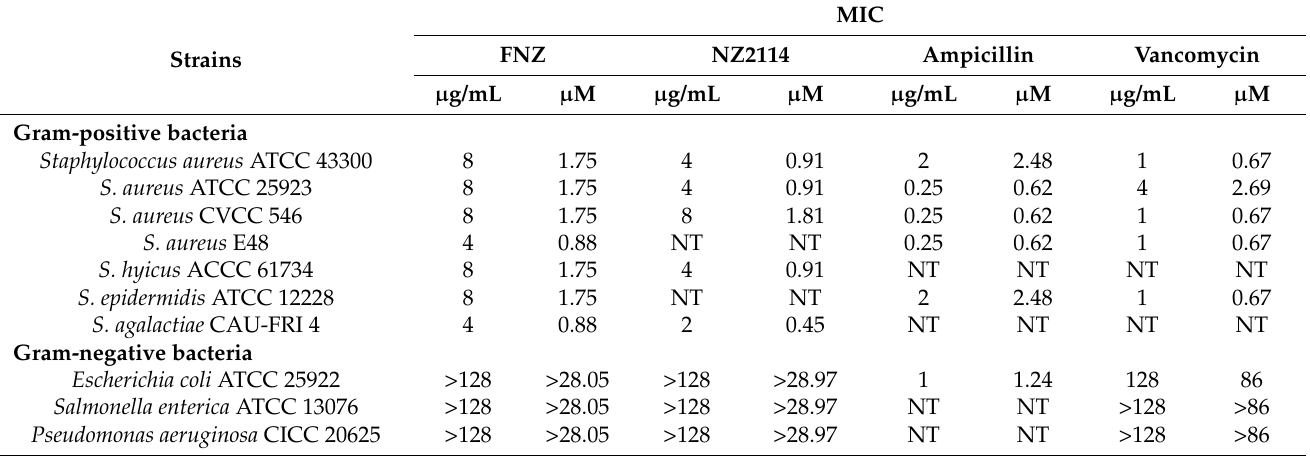
Table 1. Antibacterial spectrum of the FNZ.